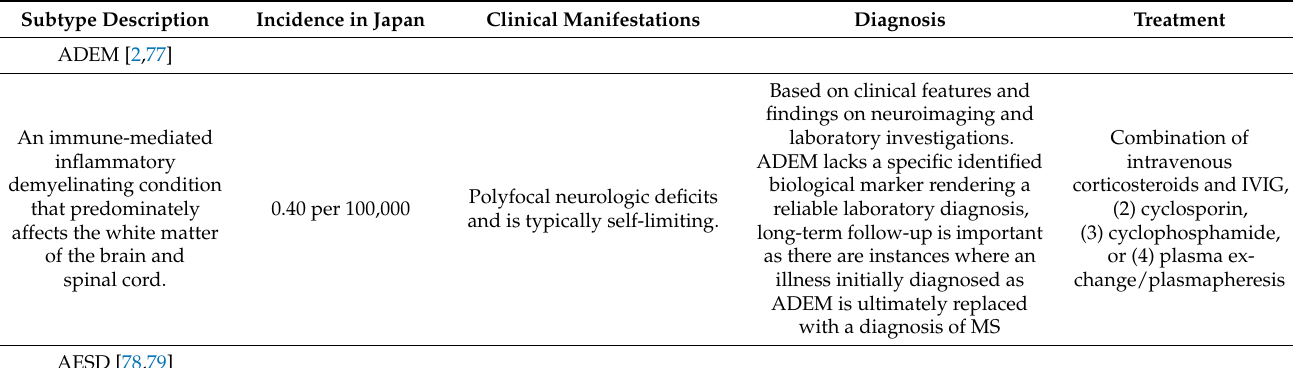
Table 5. Acute Encephalopathy in Infancy and